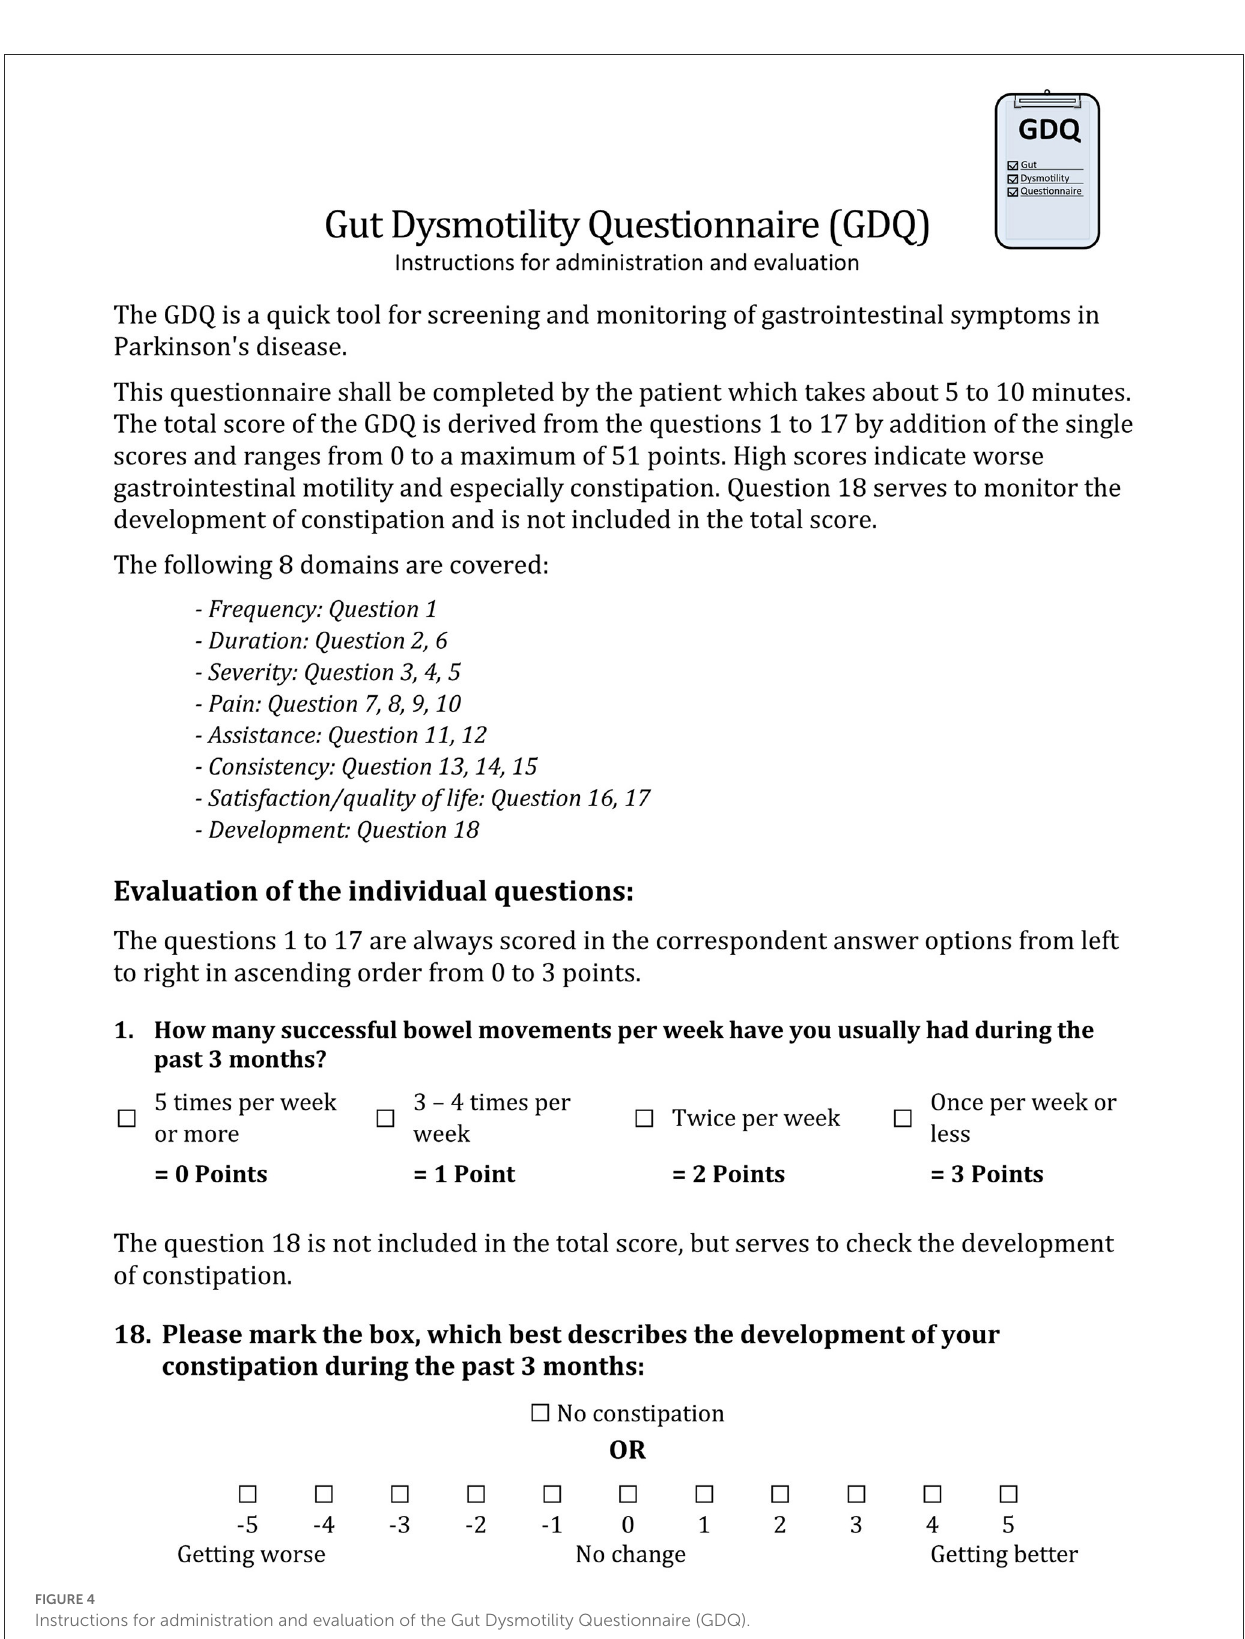
to record, i.e., “no constipation.” It was also removed from the overall rating and is designed to stand alone for the evaluation of the development of constipation intended to serve as a progress